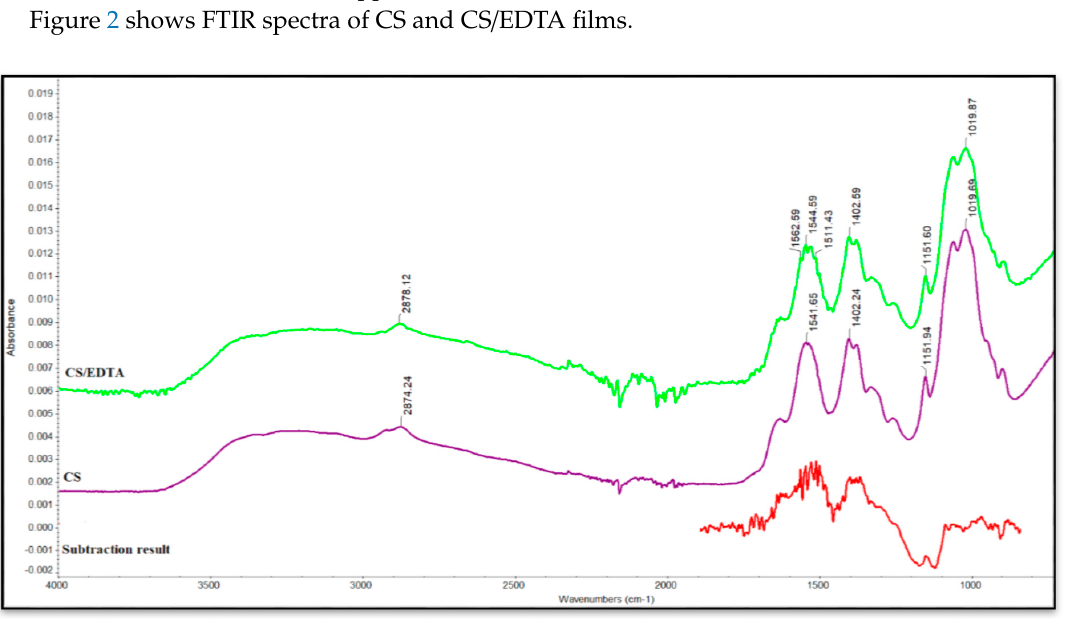
Figure 4. Scanning electron microscopy (SEM) images for GO at 1000 × (left) and 50 k× magnification (right). Figure 5 presents the surface morphology of CS.